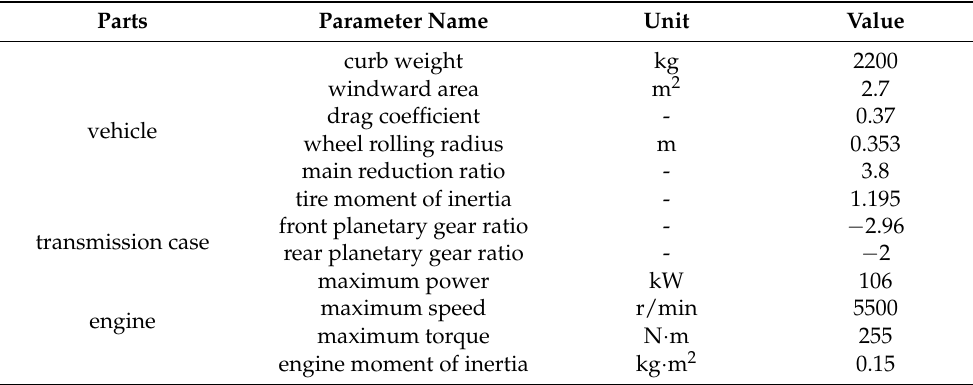
Table 2. The key parameters of the vehicle